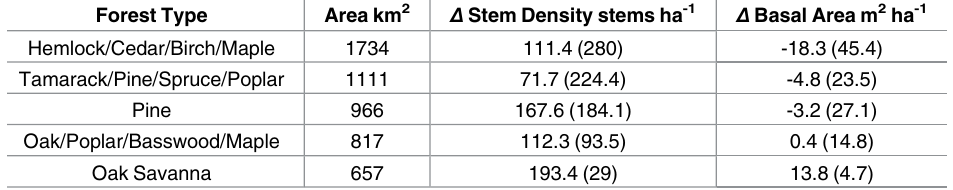
Table 2. Mean cell-wise change in forest zone density and basal area since the PLSS for cells with coveragein both PLSS and FIA eras by forest class. All forest zones show increasesin stem density since the PLSS era (positive values, historicalvalues are includedin parentheses). Oak Savanna and the Oak/Poplar/Basswood/Mapleare the only zones with increasingbasal area since the PLSS, all other zones show